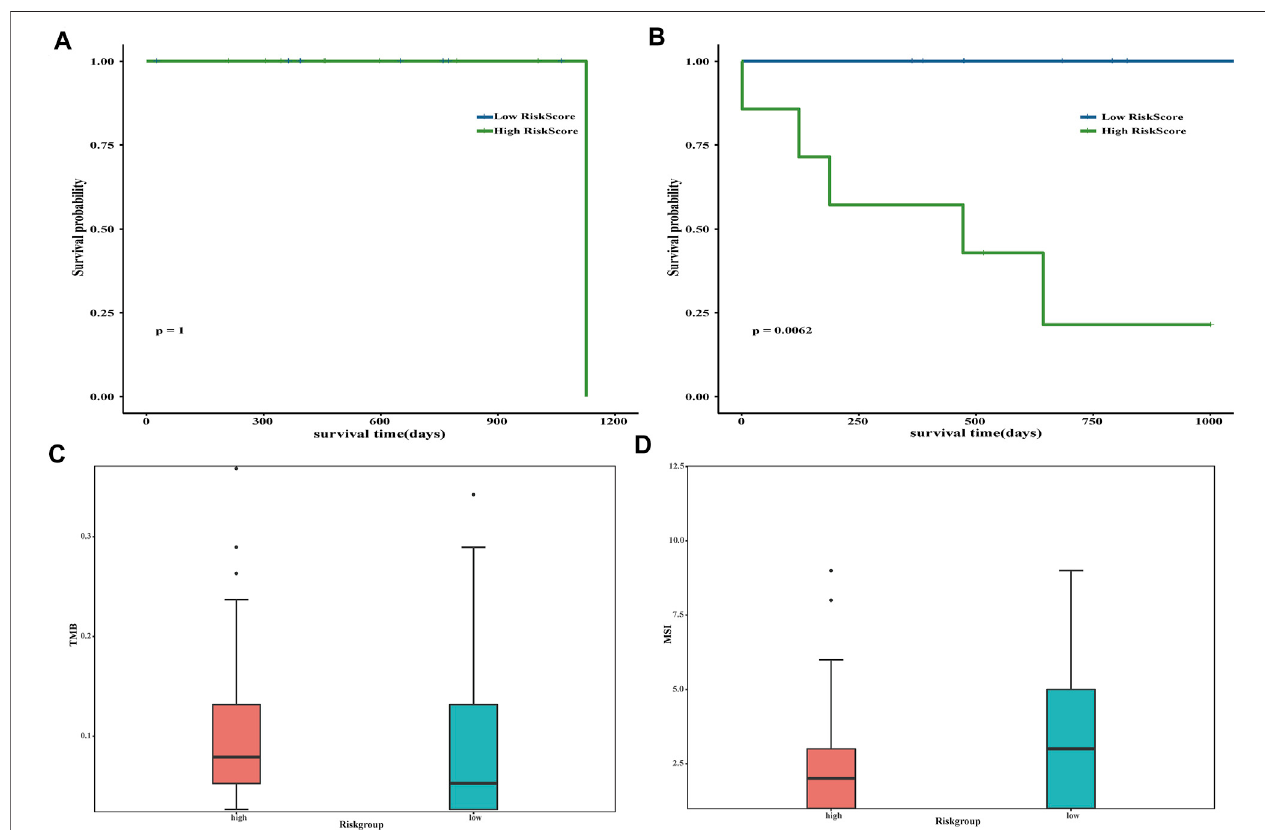
FIGURE 5 | Evaluation of risk score. The impact of risk scores on overall survival in the subgroup of inactivating mutations (A) and other non-silent mutations subgroups (B) .Blueindicateslow-riskscores,andgreenindicateshigh-riskscores.Correlationanalysisbetweentumormutationburden (C) andmicrosatelliteinstability (D) and risk scores. Pink is used to represent the group with high risk, whereas green represents the group with low